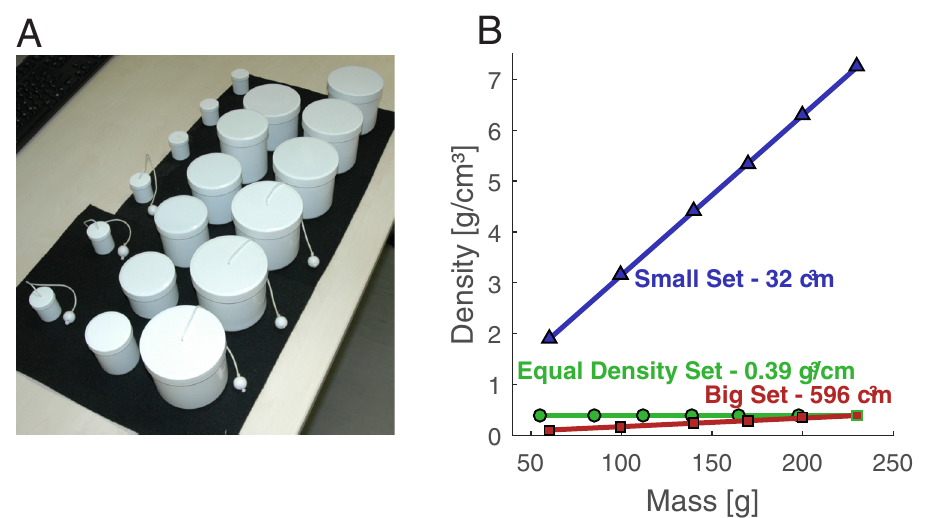
Fig 1. Stimuli and their physical parameters. (A) All stimuli used in Experiment 1 and 2. Screw caps were removable and could either be plain or attached with a string and a wooden bead. Small set objects are in the back, big set objects in the front row and equal-density objects in in-between. (B) Physical parameters of stimuli in (A). Small and big set objects were constant in volume and thus their density increased with increasing mass. This increase is more prominent in the small set. Objects from the equal density set were constant in density. The 230 g stimulus of the big set also had a density of 0.39 g/cm 3 and was also included in the analysis of the equal density set.